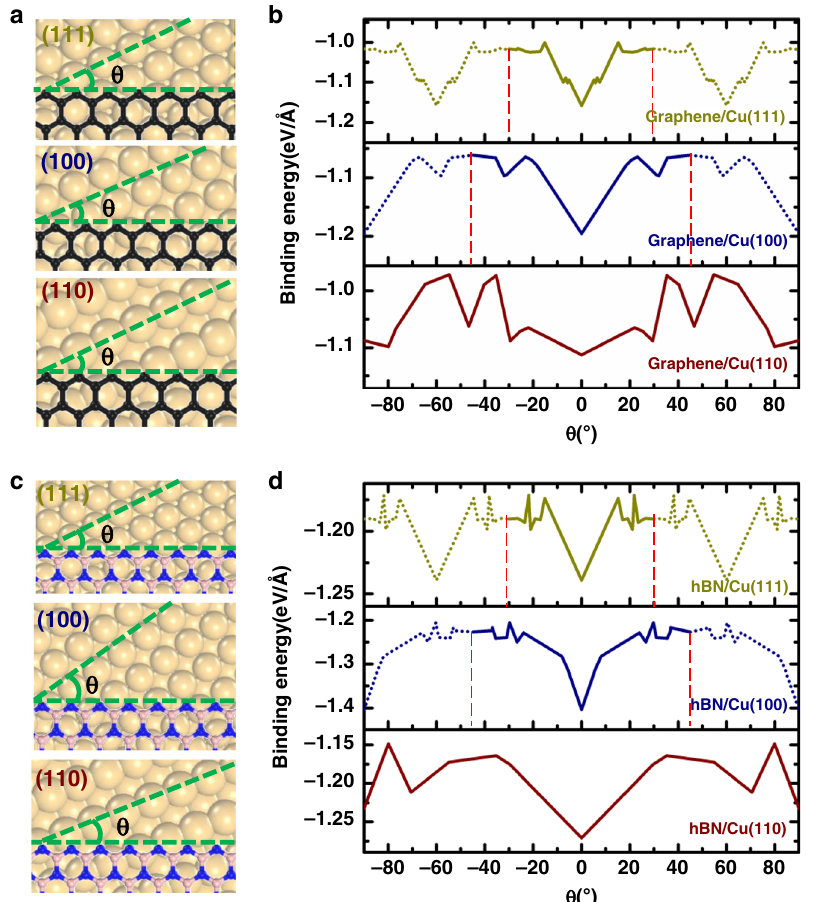
Fig. 1 Binding energy of ZZ(ZZN) edge of graphene(hBN) on three low-index Cu surfaces. Model of a graphene ZZ edge on three low-index Cu surfaces a and the calculated binding energies of the edge on the three substrates as a function of the alignment angle b . Model of a ZZN edge of hBN on the three low-index Cu surfaces c and the calculated binding energies of the edge on the three substrates as a function of the alignment angle d . Vertical lines highlight the periodicity of the binding energy